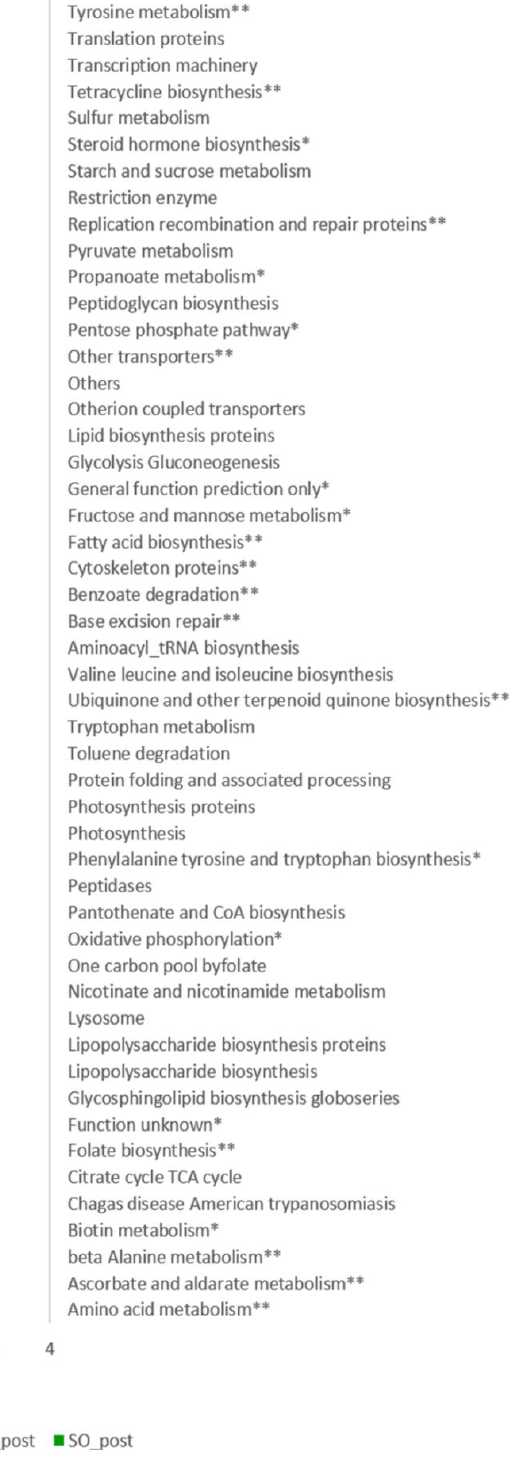
Figure 4. LDA scores of differently abundant inferred gut microbial metabolic pathways of control and SOE treated mice following the experimental period. Predicted microbial functions were inferred by PICRUSt from 16S rRNA gene sequences, which were assigned by closed reference Operational Taxonomic Units (OTUs) picking method. Control (red) and SOE (green) mice were compared by LEfSe analysis of KEGG based on level 3 pathways. Only pathways meeting LDA ≥ 2.5 and p < 0.05 are shown. * p < 0.01, ** p < 0.005.